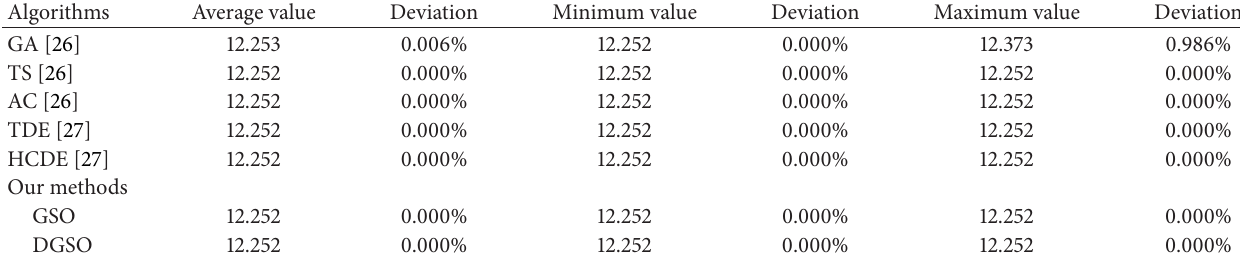
Table 2: Results for the 4 × 4